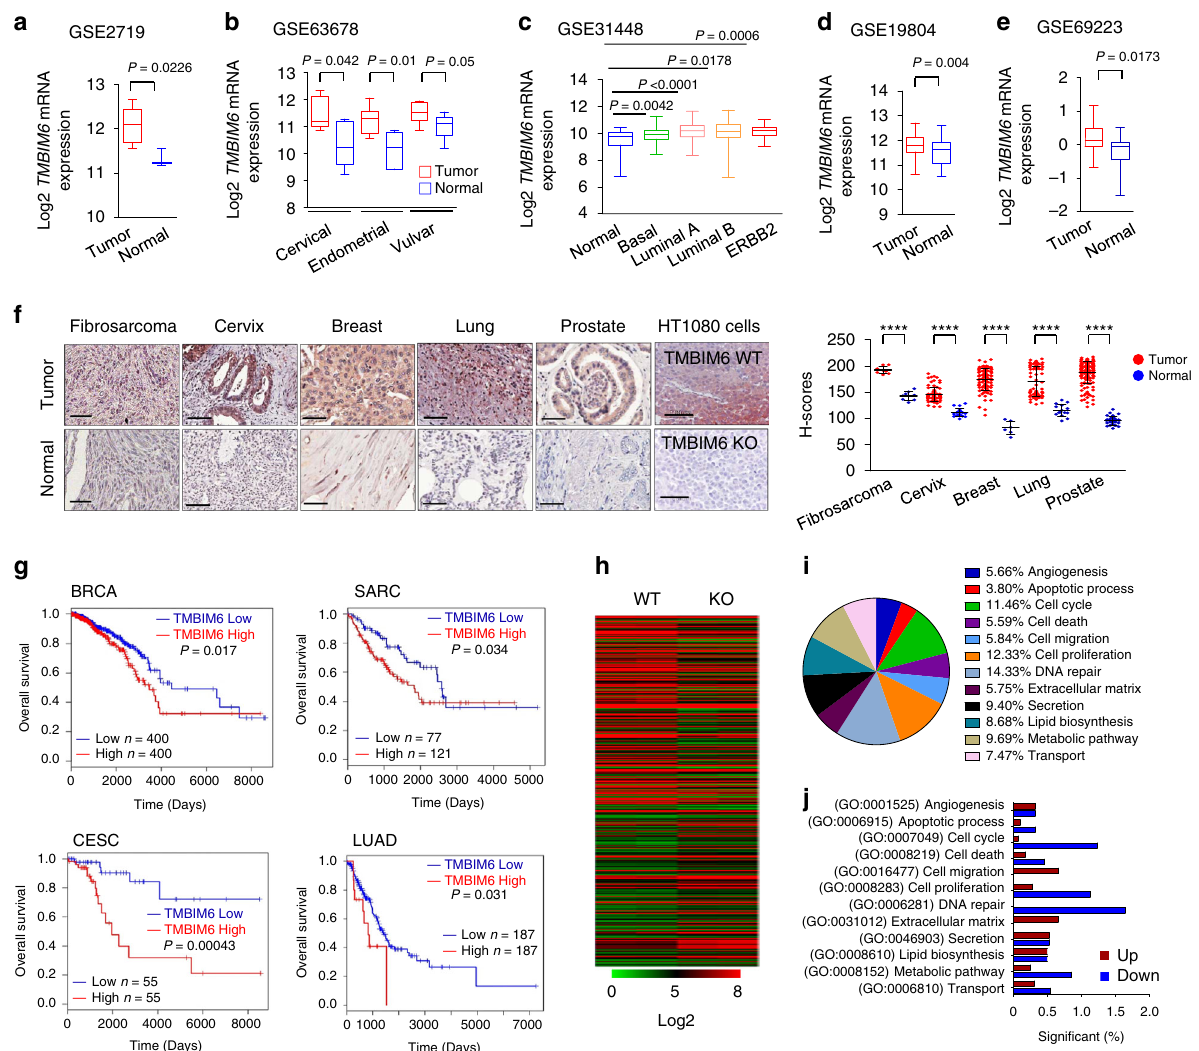
Fig. 1 TMBIM6 expression increased in cancer patient samples. a – e TMBIM6 expression was analyzed using the GEO database from NCBI. Fibrosarcoma (GSE2719; normal n = 3; tumor n = 7), cervix (GSE63678; cervical normal n = 5; tumor n = 5; endometrial normal n = 5; tumor n = 7; vulvar normal n = 7; tumor n = 6), breast (GSE31448; normal n = 31; basal n = 98; luminal A n = 89; luminal B n = 49; ERBB2 n = 25), lung (GSE19804; normal n = 60; tumor n = 60), and prostate (GSE69223; normal n = 15; tumor n = 15) datasets are presented. Center line of the box represents median; box bounds represent 25th and 75th percentiles; whiskers represent minimum and maximum values. f Representative immunohistochemical staining of TMBIM6 on tissue microarrays containing fi brosarcoma, cervix, breast, lung, and prostate tissue and adjacent normal tissues. TMBIM6 WT and KO HT1080 cells were used as a control for validation of the method. Right; quanti fi cation data of TMBIM6 expression ( fi brosarcoma normal n = 9; tumor n = 8; cervix normal n = 20; tumor n = 80; breast normal n = 6; tumor n = 97; lung normal n = 15; tumor n = 75; prostate normal n = 32; tumor n = 160). Scale bar, 100 μ m. (brown: positive antibody staining, blue: hematoxylin for nuclear staining). Data are presented as means ± SD. **** p < 0.0001, two-tailed unpaired t -test. g Kaplan – Meier curves showing the overall survival analysis in patients with high and low expression of TMBIM6 using GEPIA2 tool. P value with log-rank analysis. BRCA breast invasive carcinoma, CESC cervical squamous cell carcinoma and endocervical adenocarcinoma, SARC sarcoma, LUAD lung adenocarcinoma. h Differentially expressed genes by microarray analysis of mRNA expression levels in TMBIM6 KO and WT HT1080 cells. i Signi fi cant ratios in TMBIM6 KO and WT HT1080 cells determined by Gene Ontology analysis. j The graph indicates signi fi cant differences in downregulation and upregulation of the indicated category genes in the TMBIM6 KO cells compared with those in TMBIM6 WT cells. the known substrates of AKT, we next investigated whether in vivo experiments demonstrate that TMBIM6 regulates tumor mTORC2, upstream regulator of AKT, is altered in TMBIM6 KO growth. cells. TMBIM6 deletion decreased the phosphorylation of AKT and NDRG1 as mTORC2 substrates, and TSC2 as AKT substrate TMBIM6 activates AKT pathway through mTORC2-ribosome (Fig. 3b, Supplementary Fig. 4A – C). Immuno fl uorescence staining axis . To evaluate the signaling protein molecule, which regulates con fi rmed that the phosphorylation of AKT was decreased by the cancer progression in WT and TMBIM6 KO HT1080 cells, we TMBIM6 deletion (Supplementary Fig. 4D). Consistently, over- performed protein phospho-kinase pro fi ling analysis. The results expressing TMBIM6 in HeLa cells increased mTORC2 activity showed that the phosphorylation of AKT (pAKT-S473), PRAS40, (Supplementary Fig. 4E). Reintroducing TMBIM6 into TMBIM6 mTOR, GSK3- α / β , and WNK1 were decreased in TMBIM6 KO KO HT1080 cells restored the phosphorylation of AKT HT1080 cells (Fig. 3a). Since PRAS40, GSK3- α / β , and WNK1 are NATURE COMMUNICATIONS| (2020) 11:4012